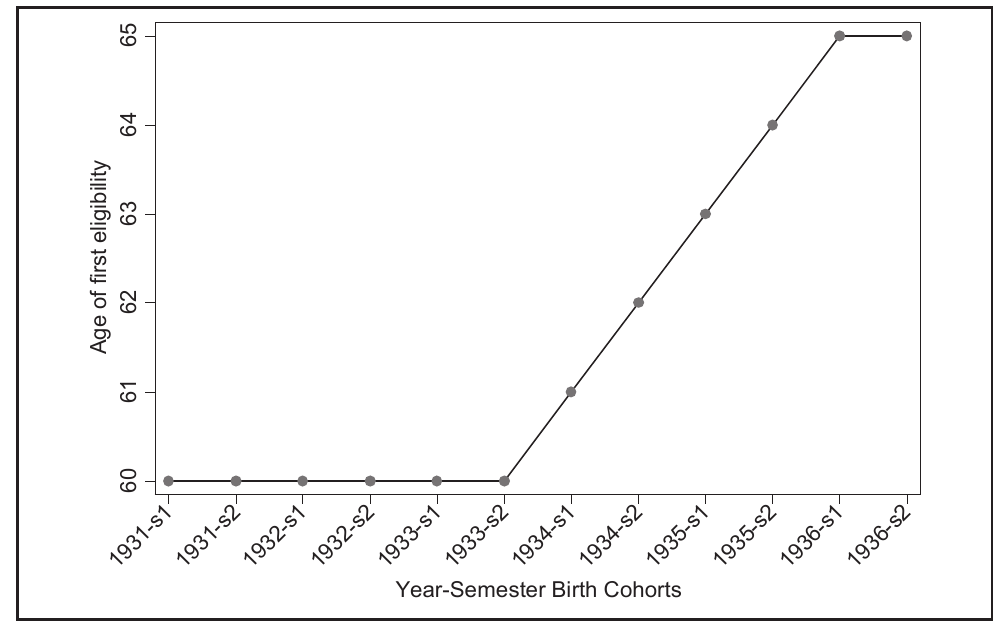
Figure 1 NRA by birth cohort as established by the 1992 Pension